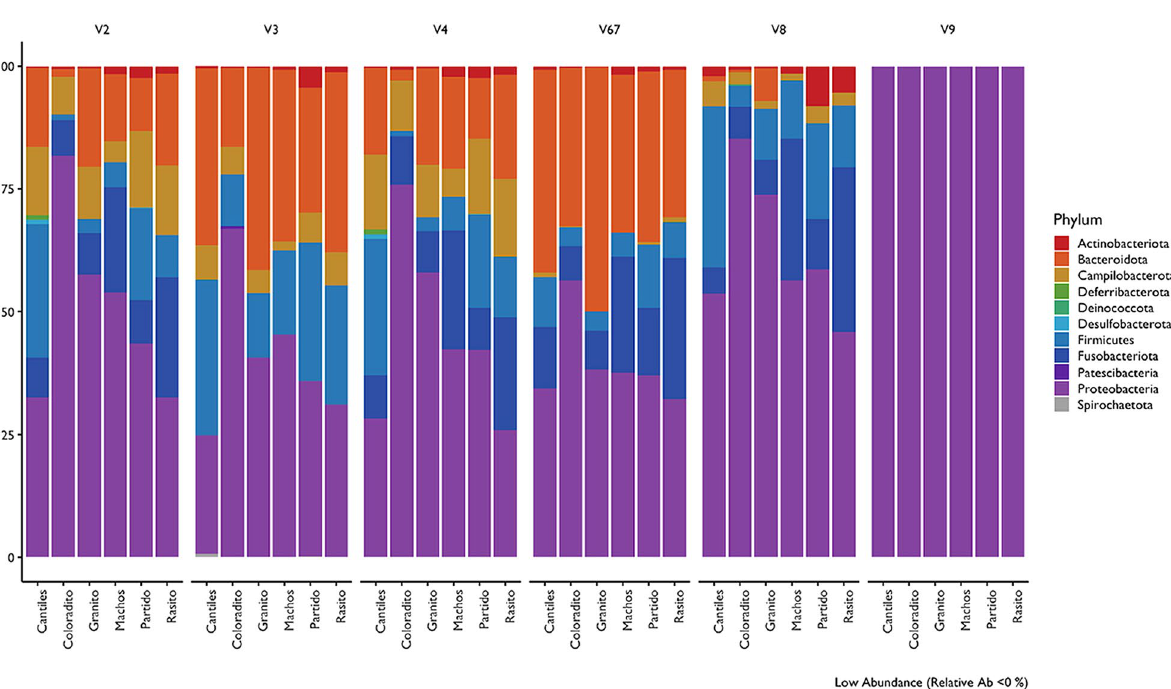
Figure 2. Major bacterial taxa (> 1% in terms of read abundance) of the gastrointestinal (GI) microbiota samples collected from six breeding rookeries (Rasito, Partido, Machos, Granito, Coloradito, and Cantiles) in the Gulf of California (GoC). The DNA samples were pooled (see methods) and taxa were detected from each hypervariable region (V2 to V9) of 16S